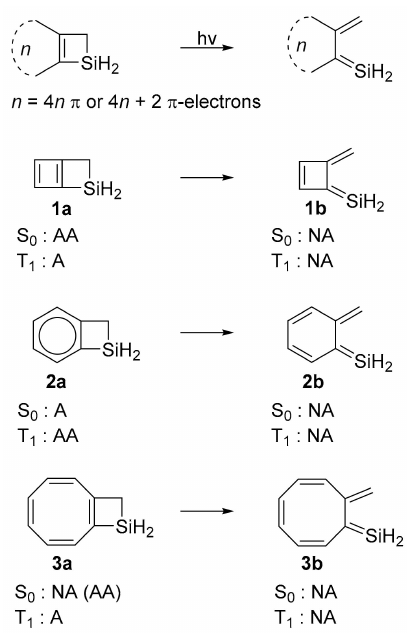
Figure 2. The annulenoSCB ring-openings and the postulated (anti)aromatic characters in the S 0 and the T 1 states of 1a , 2a , 3a , 1b , 2b , and 3b , respectively, with A = aromatic, AA = antiaromatic, and NA =